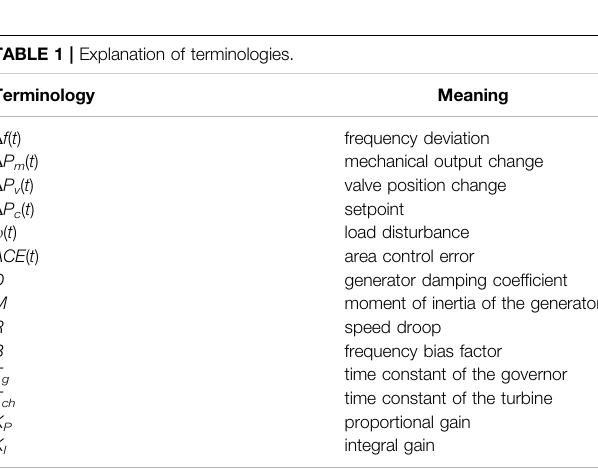
TABLE 1 | Explanation of